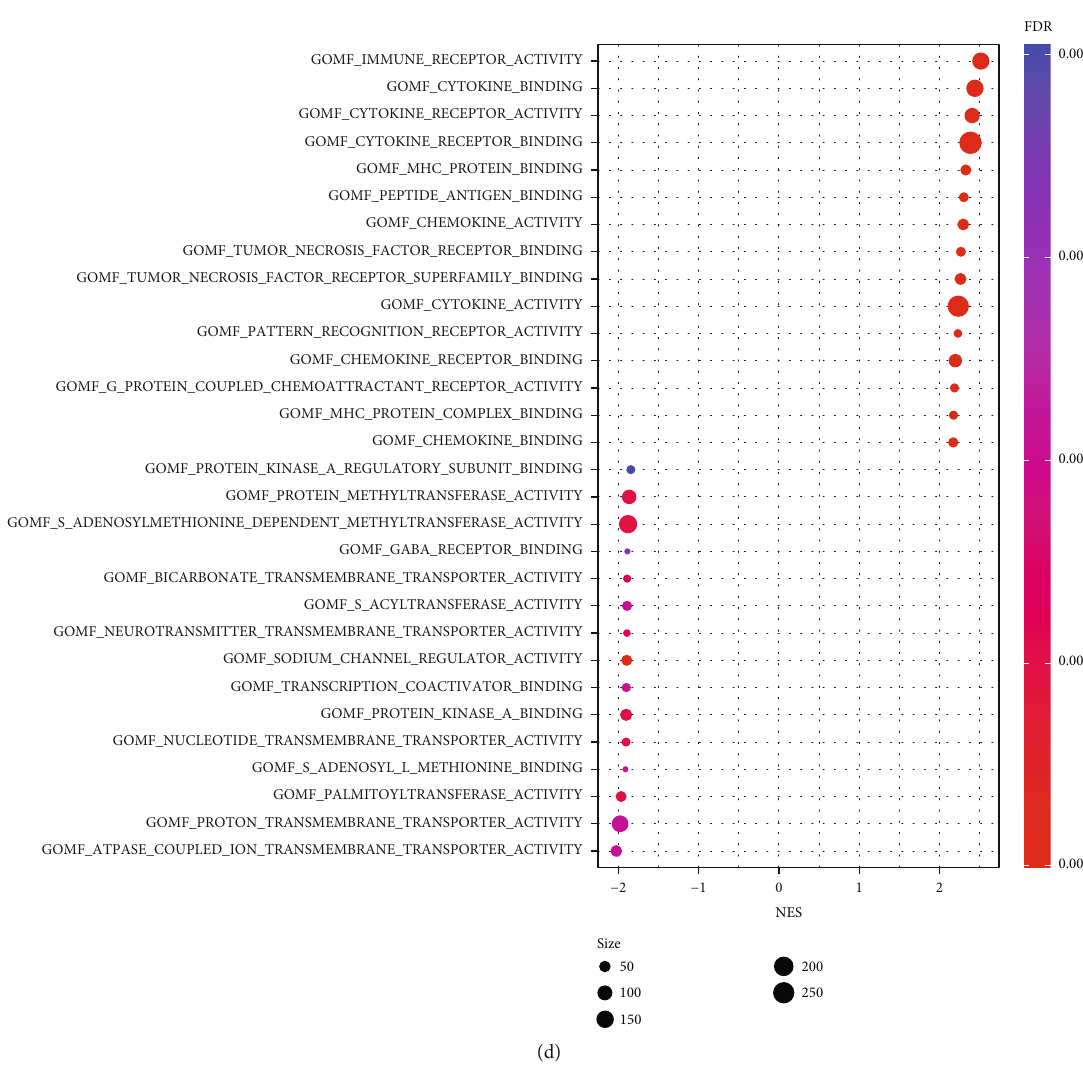
Figure 3: The GO and KEGG pathway analyses of Immunity_H and Immunity_L in KIRC. (a) Biological processes involved in Immunity_ H and Immunity_L. (b) Cellular components involved in Immunity_H and Immunity_L. (c) Molecular functions involved in Immunity_H and Immunity_L. (d) KEGG pathways involved in Immunity_H and